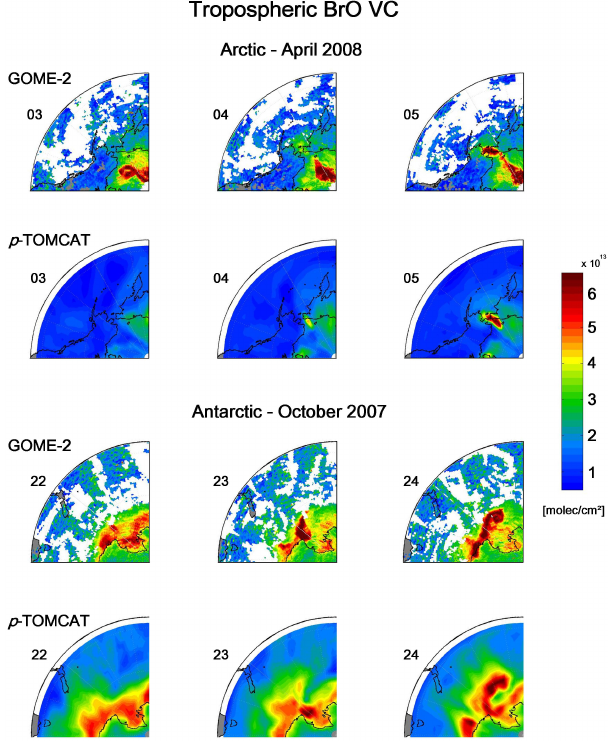
Fig. 9. Tropospheric BrO vertical columns from GOME-2 (satel- lite) and p-TOMCAT (model) including bromine emissions from sea salt aerosol production through blowing snow events across the Chukchi Sea region of Arctic from 3 to 5 April 2008 (upper panels) and over the Ross Sea of Antarctica from 22 to 24 October 2007 (lower panels). Taken from Theys et al. (2011) with permission of the